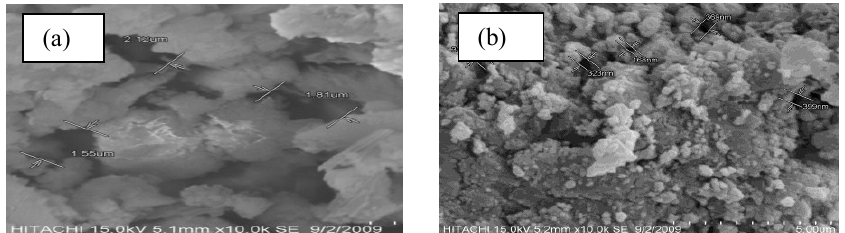
Figure 3. Scanning Electron Micrograph (SEM) of EAFS (a) before adsorption (b) after